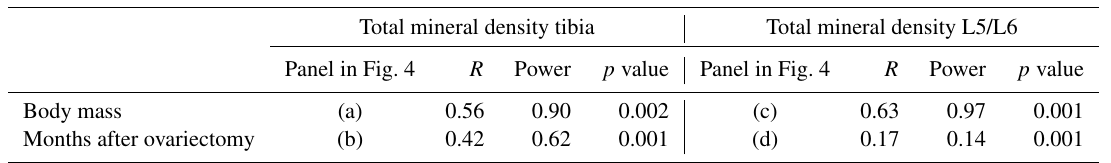
Figure 4. Total mineral density and regression line in proximal tibia vs. body mass (a) or vs. months after ovariectomy (b) and total mineral density in the second-last lumbar vertebrae (L5/L6) and regression line vs. body mass (c) or vs. months after ovariectomy (d) in six female marmoset monkeys. Corresponding statistical data are summarized in Table 1. Table 1. Regression statistics of total mineral density in proximal tibia and in the second-last lumbar vertebrae (L5/L6) vs. body mass or vs. months after ovariectomy. Data plots and regression lines are shown in Fig.